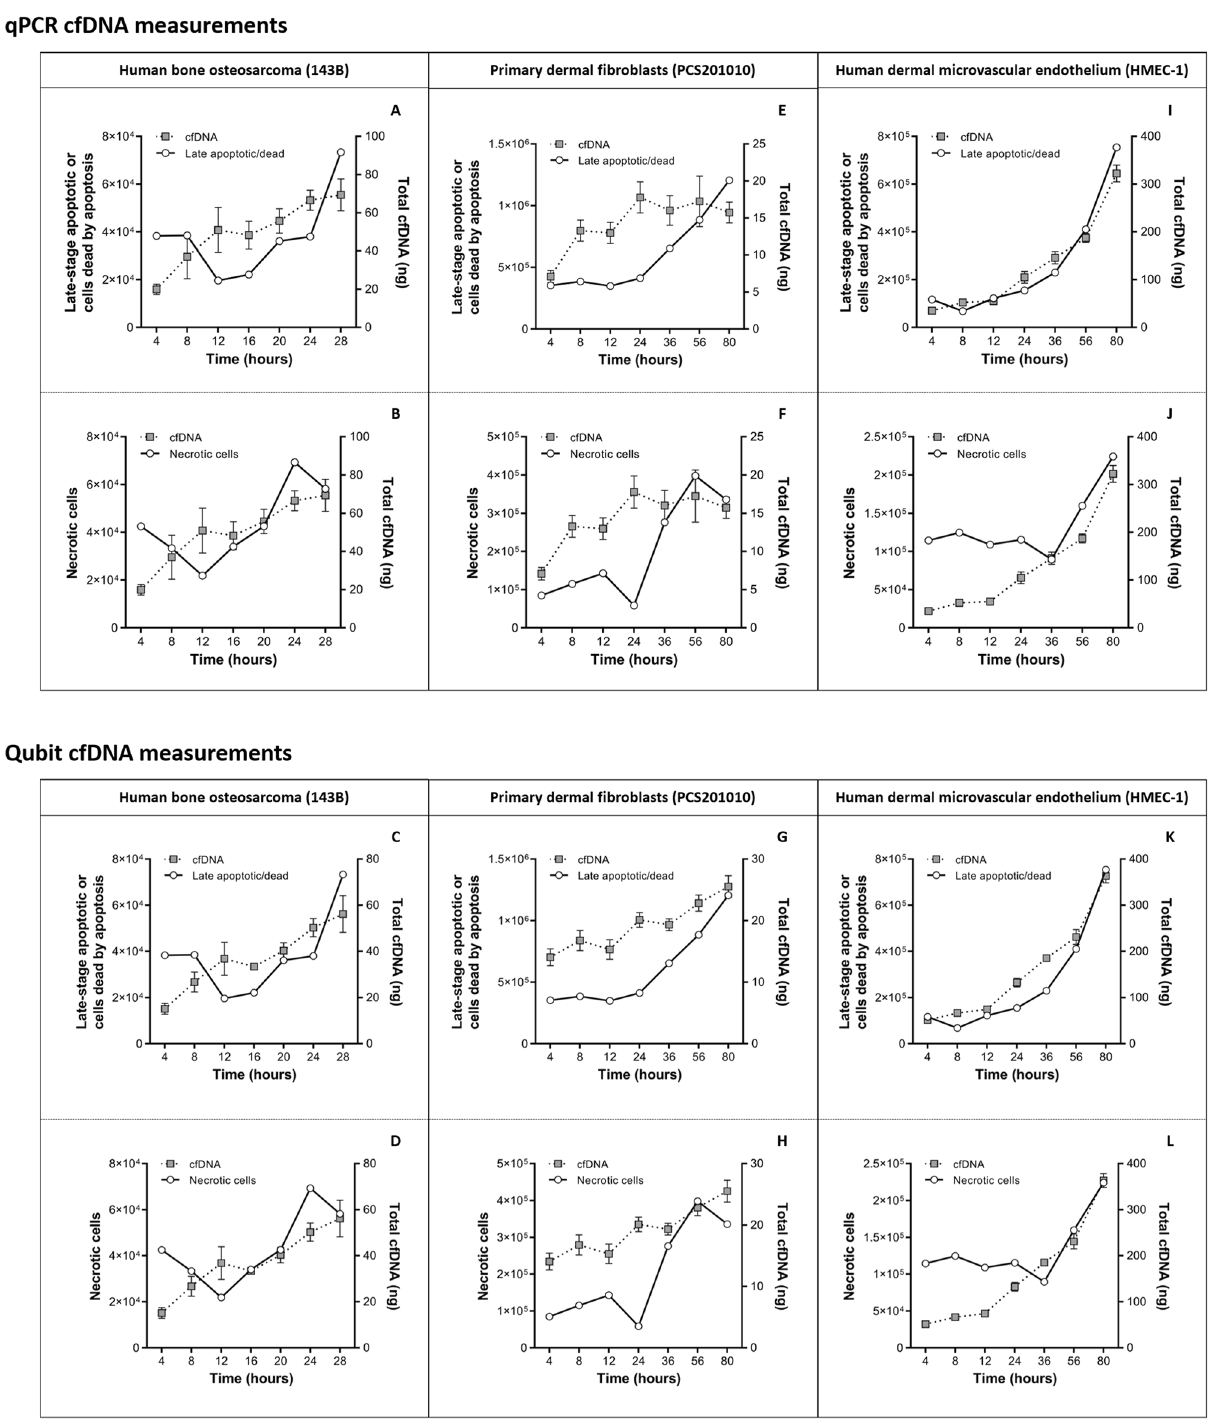
Figure 3. Total cfDNA levels vs total number of apoptotic and necrotic cells. Changes in total cfDNA levels as measured by both the β-globin-based qPCR ( top ) and Qubit HS DNA ( bottom ) assays over increasing incubation periods was plotted against corresponding changes in the total numbers of apoptotic and necrotic cells, respectively, as determined by a caspase-3/7 assay. (A-D) Human bone osteosarcoma (143B), (E–H) primary dermal fibroblasts (PCS201010), and (I-L) human dermal microvascular endothelial (HMEC-1) cell lines were investigated to observe the time-dependent changes in absolute cfDNA levels and corresponding changes in the total number of late-stage apoptotic cells or cells already dead by apoptosis ( A , E , I , C , G , K ), and necrotic cells ( B , F , J , D , H , L ). cfDNA values represent the total mass (ng) of cfDNA in the cell culture supernatant after each incubation period. Linear regression analyses for total cfDNA vs total apoptotic and necrotic cells are summarized in Supplementary Table